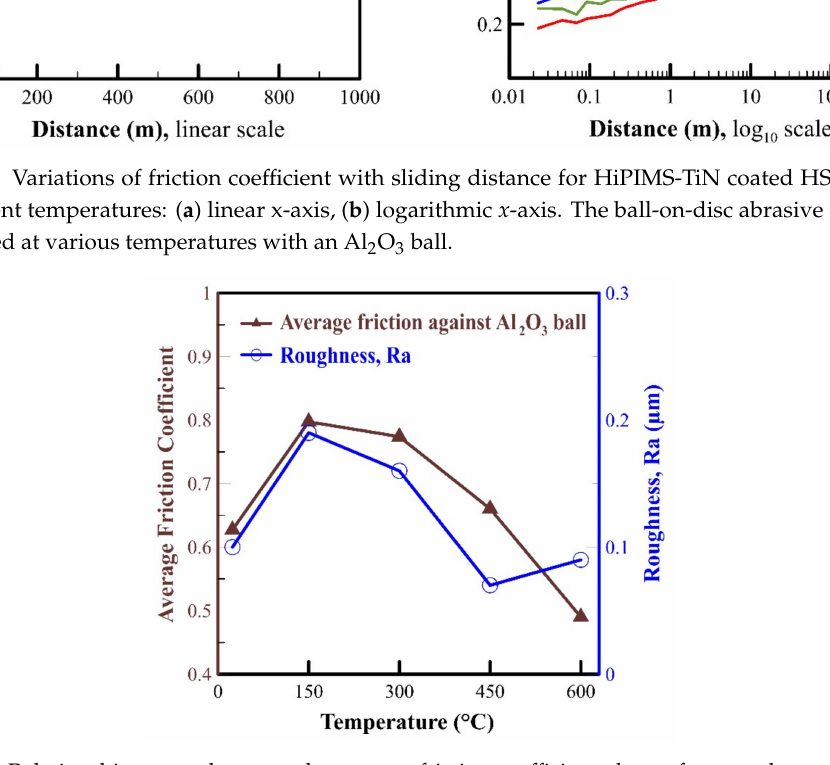
Figure 7. Relationship curves between the average friction coe ffi cient, the surface roughness, and the wear test temperatures. Table 3. Abrasive processes at high temperatures result in di ff erent e ff ects on the mechanism properties of